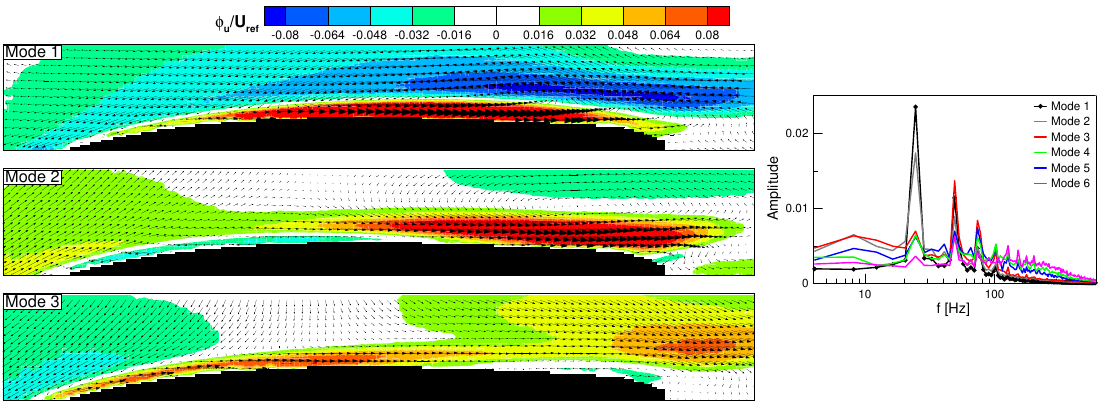
Figure 7. The POD modes (left) and Fourier spectra of POD eigenvectors (right) for the halved f +